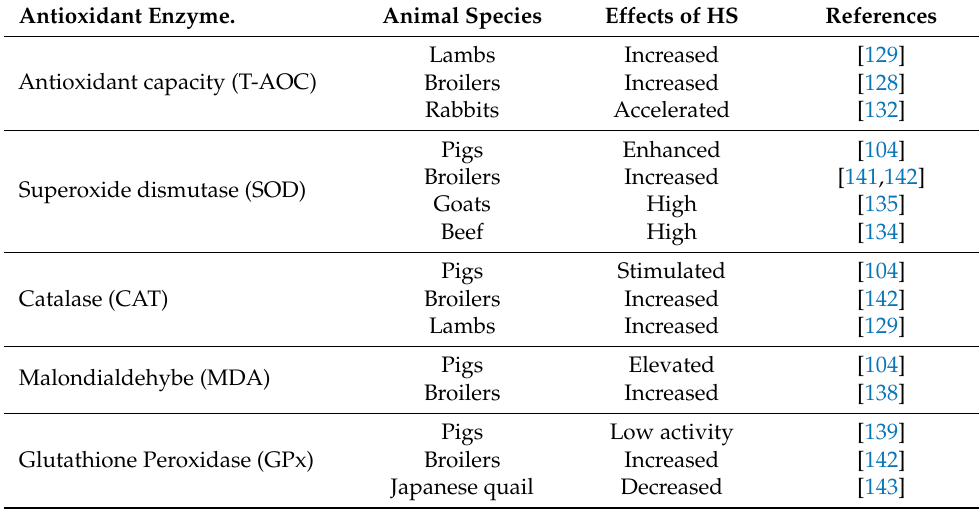
Table 2. Variation of antioxidant enzymes activity under heat stress. Antioxidant Enzyme. Animal Species Effects of